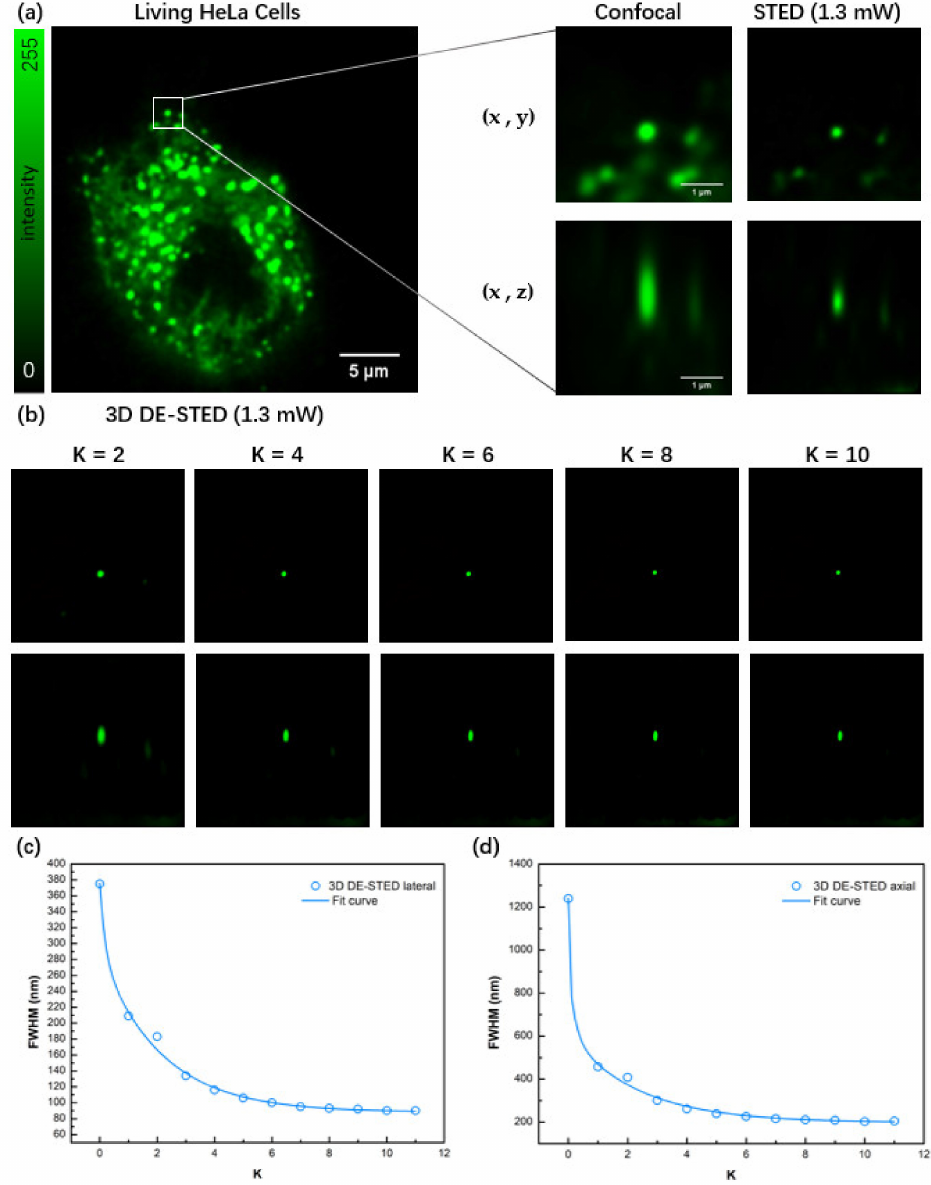
Figure 7. 3D DE-STED imaging of lysosomes in living HeLa cells. ( a ) Confocal image of a whole HeLa cell and enlarged confocal and STED images in the white square. ( b ) 3D DE-STED images with the increase in K value. The field of view (FOV) is 4.15 µ m. ( c , d ) Curves of the lateral and axial relationship between the FWHM and the K value. Its optimal K value is